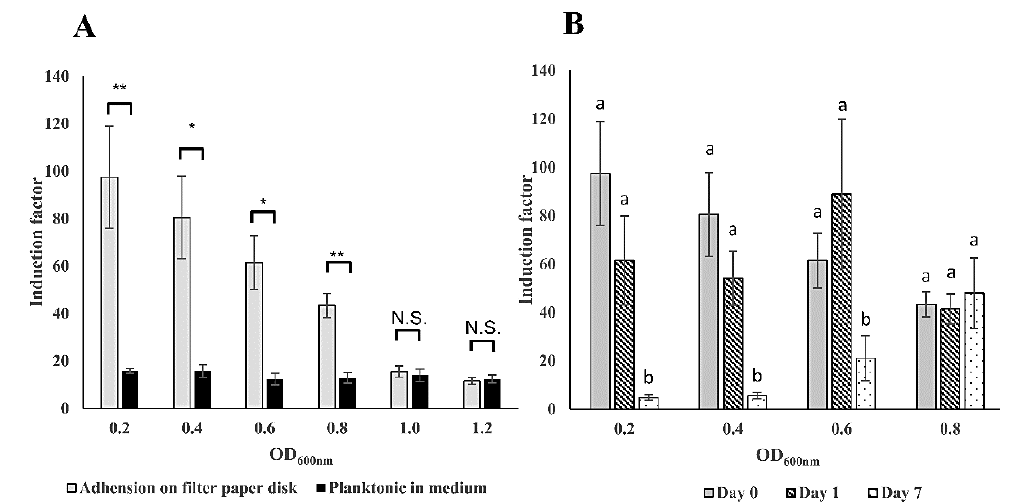
Figure 4. Sensitivity and stability of the immobilized bacteria cells on filter membrane disks. ( A ) Comparison of the sensitivity to 2% ( v / v ) ethanol between filter membrane adhered and planktonic forms of E. coli luminescent strain TV1061 in di ff erent optical densities at OD 600 nm . ( B ) Stability of the sensitivity to 2% ( v / v ) ethanol during storage of filter membrane adhered E. coli strain TV1061 at − 20 ◦ C for one day and seven days. All the values in the graphs are presented as mean ± standard error of the mean (SEM), with “*” for p < 0.05, “**” for p < 0.01, and “N.S.” for “Not Significant” ( p > 0.05), which were calculated by using the student’s t -test. Di ff erent letters above the bars indicate significant di ff erences ( p < 0.05) that were tested by the Fisher’s Least Significant Di ff